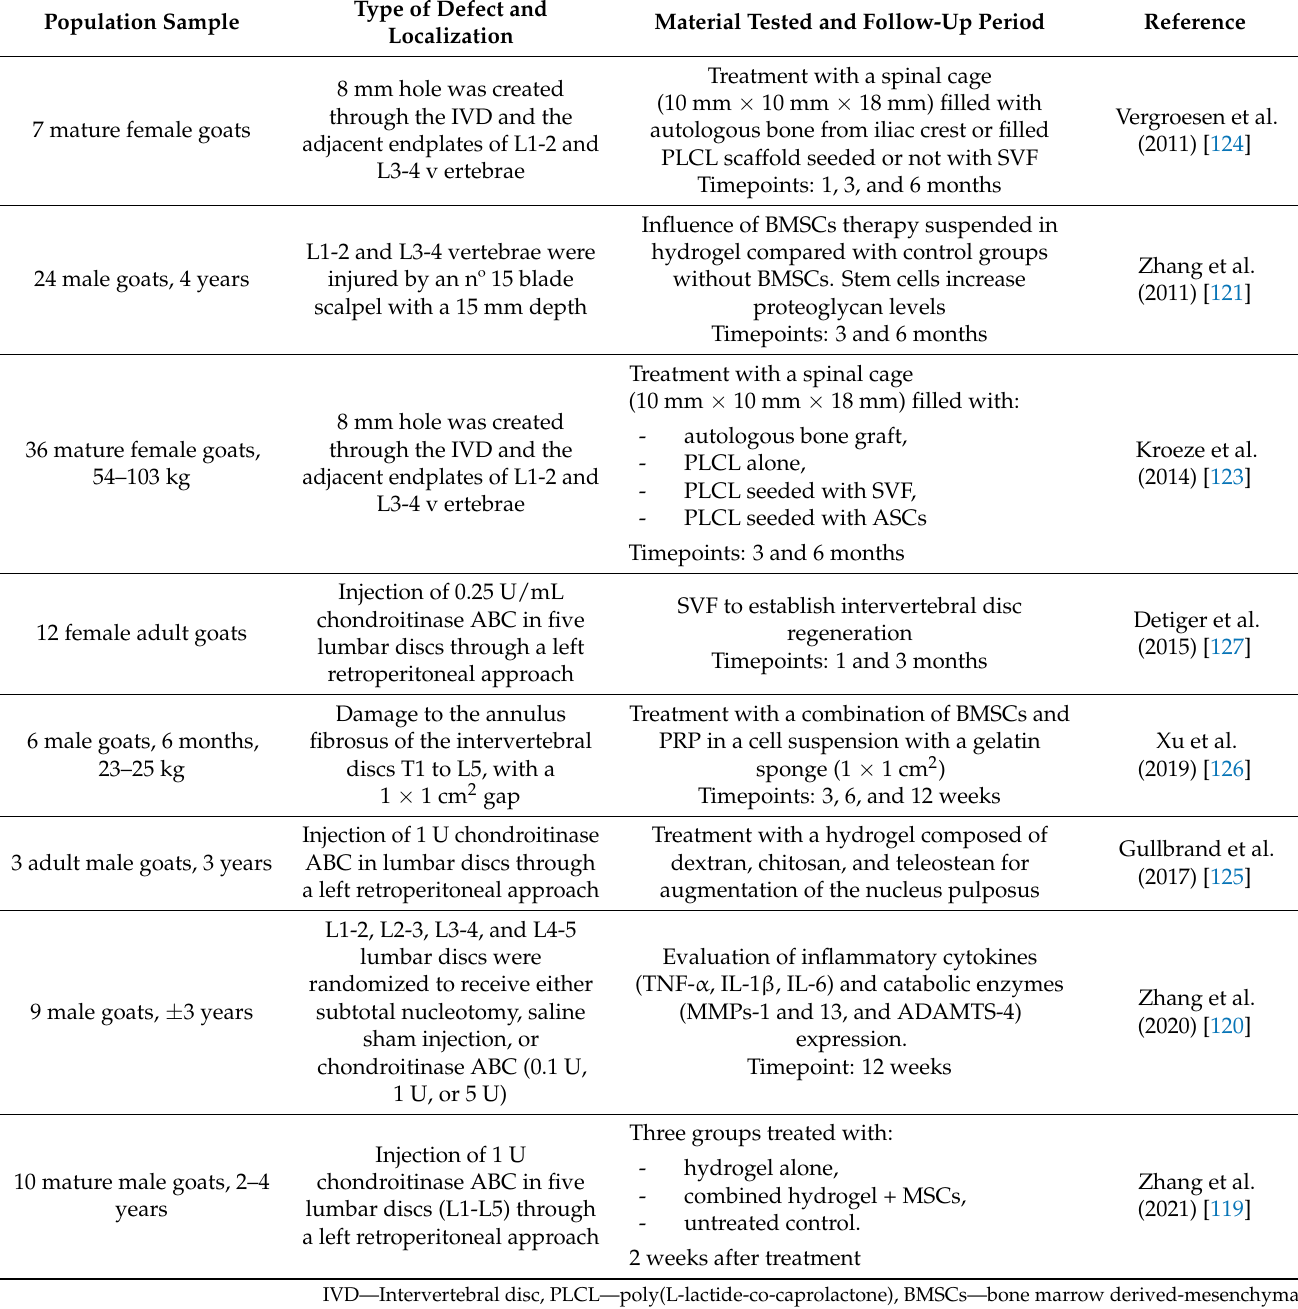
Table 4. MSCs studies in the caprine model for vertebral column